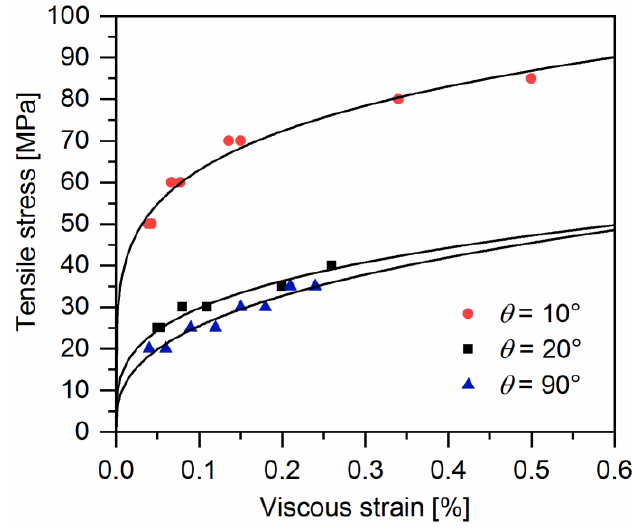
Figure 9. Experimental data of the axial stress-viscous strain of a quasi-UD E-glass/polypropylene composite subjected to off-axis tensile loading.